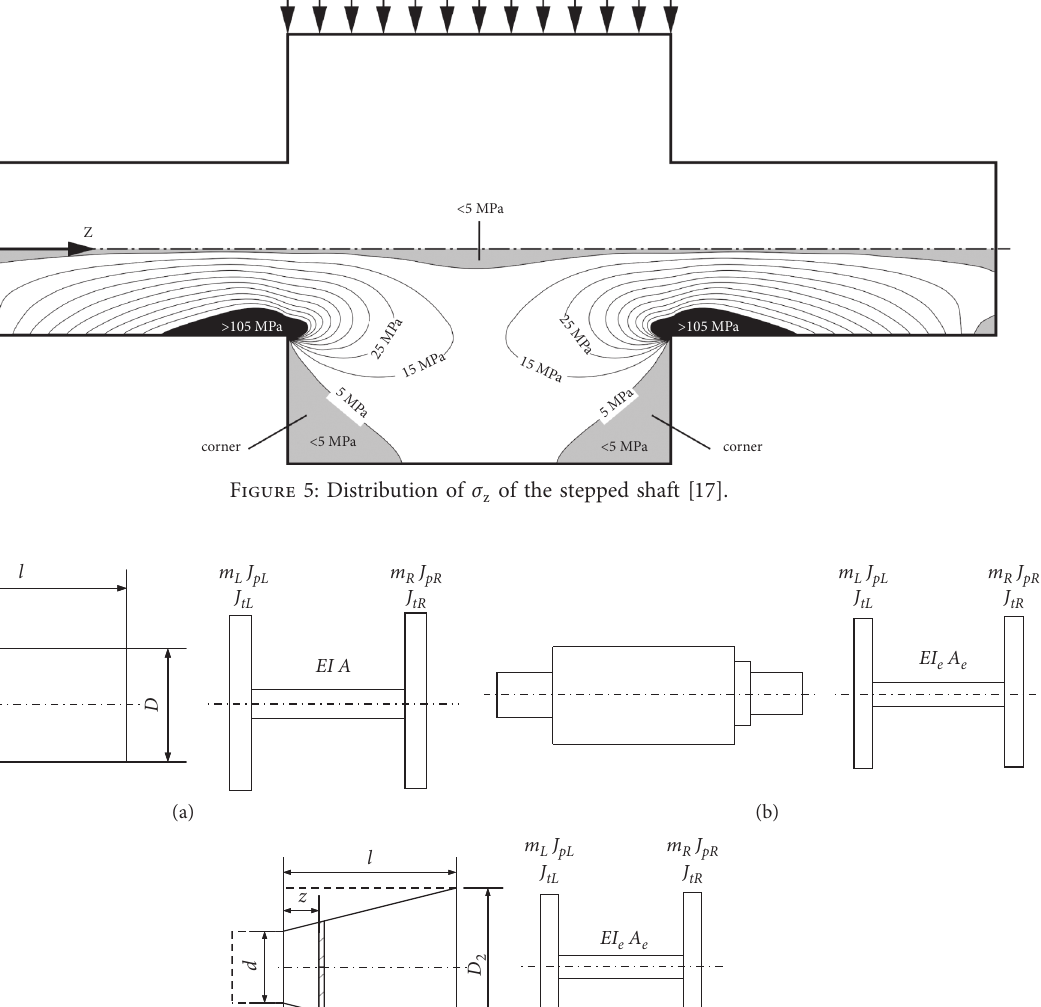
Figure 6: The lumped mass model of (a) the cylindrical shaft, (b) the multiple shaft, and (c) the conical